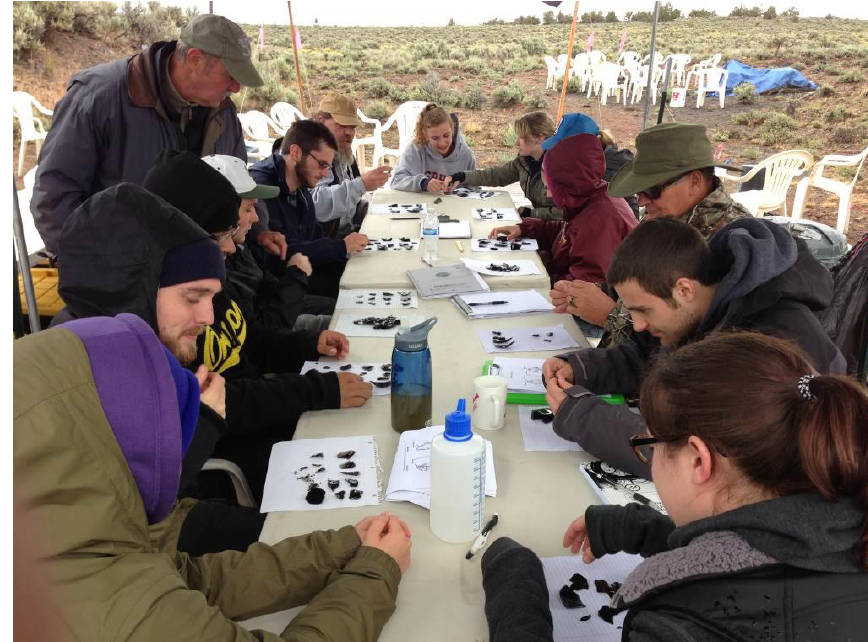
Figure 1. Michael Rondeau instructing students on flake attribute analysis. (Photo by Patrick O’Grady.)